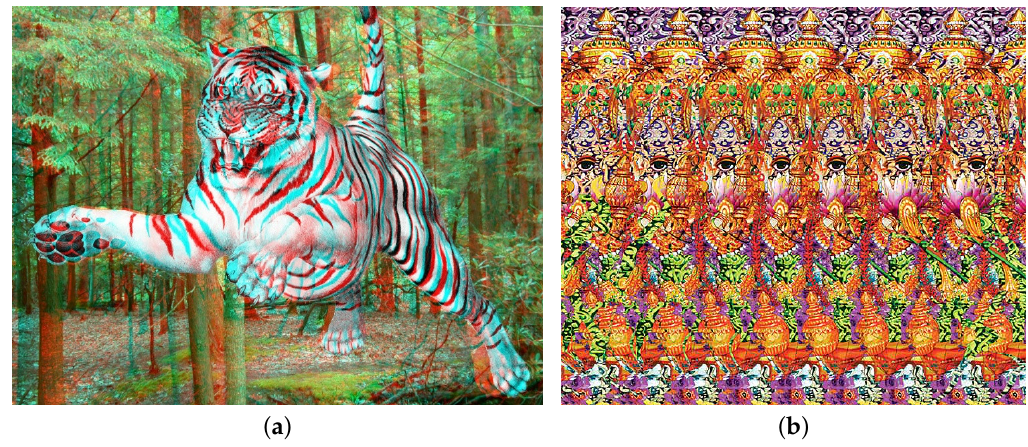
Figure 4. Examples of anaglyphic and stereogram images. ( a ) A anaglyphic image; ( b ) A stereogram image.